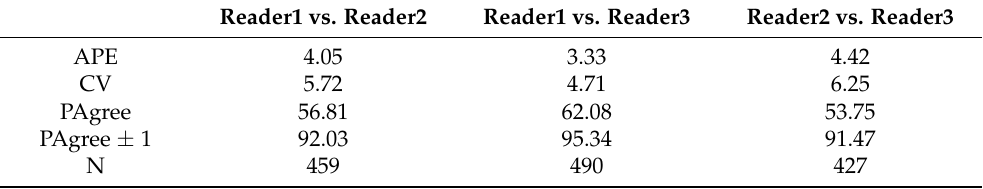
Table 1. Precision indices for age readings of Trachurus picturatus from Portuguese continental coast. APE—average percentage error; CV—average coefficient of variation; PAgree—percentage of perfect agreement; PAgree ± 1—percentage of agreement within one year interval; N—number of otoliths read. Reader1 vs. Reader2 Reader1 vs. Reader3 Reader2 vs. Reader3